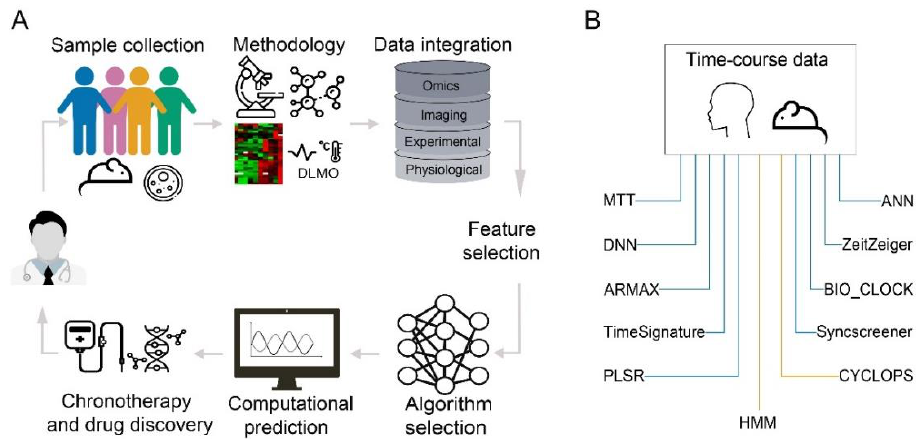
Figure 4. Schematic workflow of a computational prediction pipeline using machine learning based algorithms and possible applications in personalized medicine. ( A ) Inter-disciplinary data collected from human subjects, animal and cell line models are integrated using computational methods. The integrated data is then examined and features (variables) depicting potentially relevant information for the prediction model are selected. Based on the complexity of features and the prediction goal, an algorithm is selected and the computational prediction takes place. The prediction model can produce knowledge that serve as the basis for chronotherapy planning. ( B ) Schematic representation of supervised (blue lines) and unsupervised (yellow lines) machine learning algorithms used to predict circadian parameters based on genomics or physiological data.